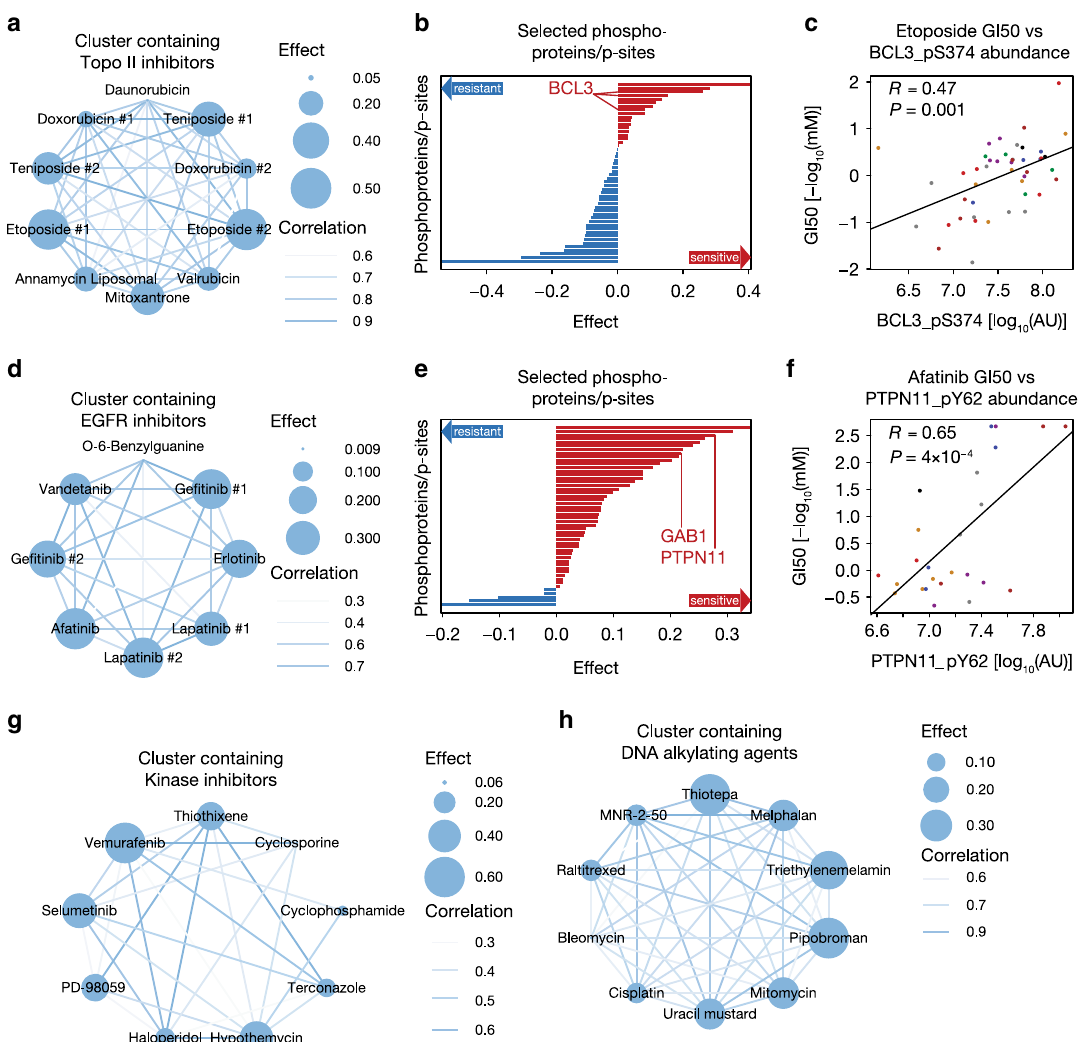
Fig. 5 Common markers explain sensitivity to drugs sharing the same mode of action. a Cluster containing several Topoisomerase II inhibitors identi fi ed by sparse multiblock partial least square regression (SMBPLSR). Nodes represent compounds with size indicating effect size (SMBPLSR score of drugs; Supplementary Methods), while edges visualize the correlation of the sensitivity between two drugs across cell lines (white = low, blue = high). b The bar plot shows phosphoprotein and p-site markers associated with drugs in the network depicted in the left panel (red = sensitivity marker, blue = resistance marker). c Selected markers include multiple p-sites on BCL3, one of which (BCL3_pS374) is signi fi cantly (Pearson correlation test; P < 0.05) positively correlated with Etoposide sensitivity (right panel; n = 52 cell lines). Cell lines are colored by tissue of origin. d Same as in panel a , but for the drug cluster containing mainly EGFR inhibitors. e Here, GAB1 and PTPN11 phosphoproteins are selected as sensitivity markers (middle panel). f PTPN11_pY62 shows signi fi cant (Pearson correlation test; P < 0.05) positive correlation with Afatinib (right; n = 52 cell lines). ( g , h ) Networks of drug clusters driven by g